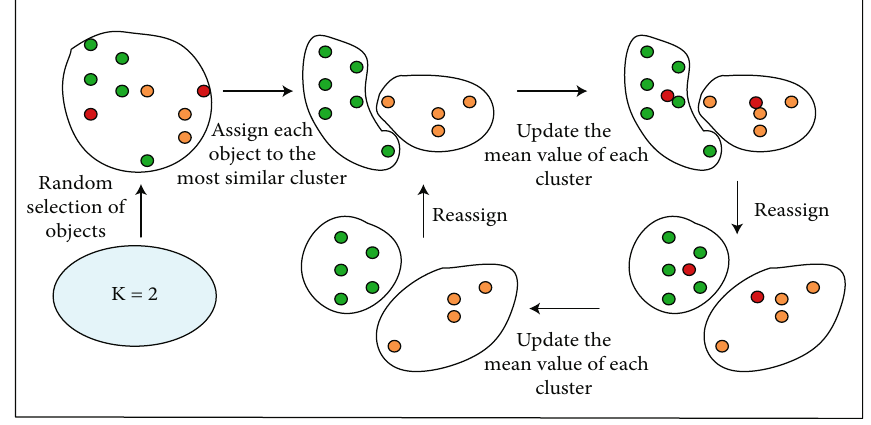
Figure 1: Schematic diagram of